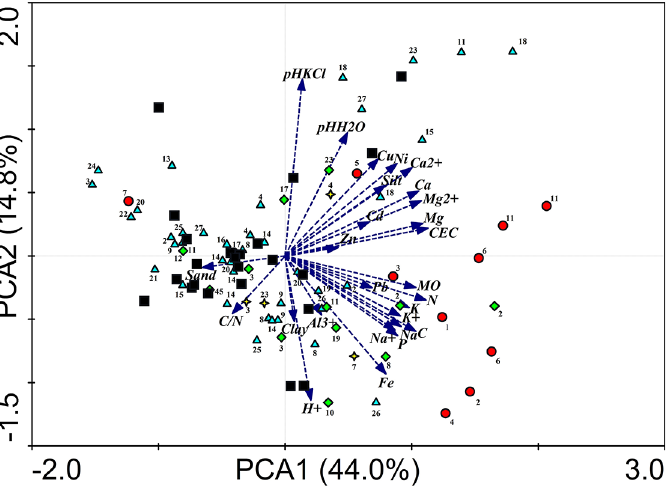
Fig 3. PCA bi-plot of termite samples and environmental variables depicting the first and second axes. Black filled squares: controls; light blue-filled triangles: termites sampled in soil; red-filled circles: termites sampled in abandoned nests; yellow-filled stars: termites sampled at tree basis; green-filled diamond: termites sampled at the basis of palmtree. 1. A . banksi ; 2. A . nigripunctatus ; 3. A . jheringi ; 4. A . nr distans ; 5. Apara . cingulatus , 6. Apara . sp A; 7. Grigio . sp A; 8. Longusti . manni ; 9. A . sp B; 10. A . sp C, 11. A . sp E1; 12. A . sp E3; 13. A . sp I; 14. A . sp N; 15. A . sp S; 16. A . sp T; 17. A . sp Y; 18. A . sp Y2; 19. A . sp AB; 20. A . sp AD; 21. A . sp AE; 22. A . sp AF; 23. A . sp AM; 24. A . sp AN; 25. A . sp AP; 26. A . sp AW; 27. Unidentified